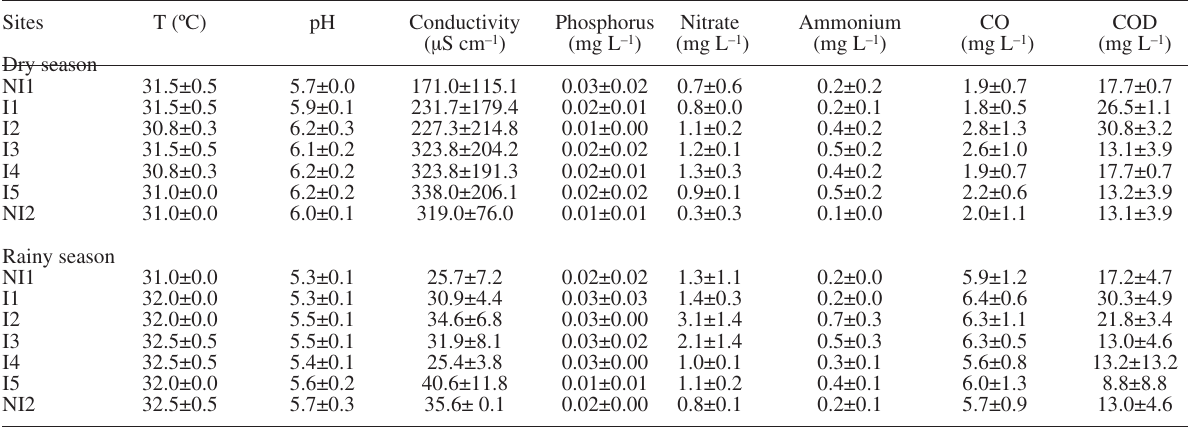
Table 1. – Water physical and chemical characteristics. Values (mean±SE) are shown for each sampling season. I, impacted sites; NI, non- impacted sites; T, temperature; CO, consumed oxygen; COD, chemical oxygen demand. Sites